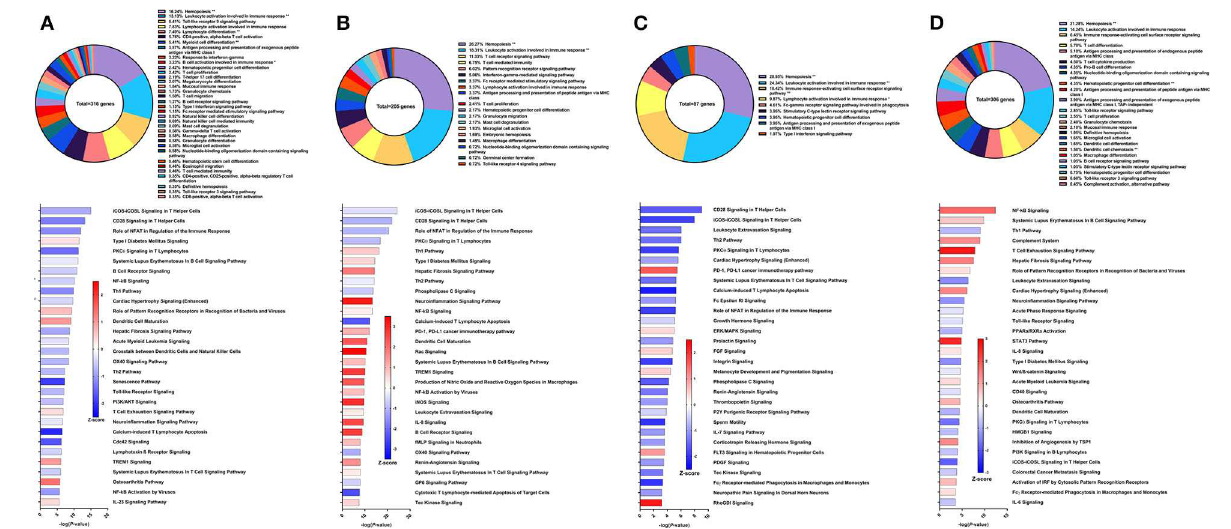
FIGURE 3 | RNA-Seq analysis of Sm-p80-VR1020 + rSm-p80 + ODN10104, a prime/boost vaccine strategy. (A) PBMCs after vaccination (Top) Gene ontology enrichment analysis represented as a pie graph of percentages of genes per group out of a total number of differentially expressed genes. “**” and “*” indicates P < 0.05 and P < 0.01, respectively. (Bottom) Canonical pathway analysis generated using IPA. Bars are plotted based on the – log10( P -value) and colored based on predicted activation (red) and deactivation/inhibition (blue) according to the Z-score, a composite assessment based on the degree of overlap between directional expression of genes from the observed data and the Qiagen-curated public database. The top 30 pathways are shown based on the lowest P -values. (B) PBMCs after challenge (Top) Gene ontology enrichment analysis. (Bottom) Canonical pathway analysis generated using IPA. (C) Spleen cells (Top) Gene ontology enrichment analysis. (Bottom) Canonical pathway analysis generated using IPA. (D) Mesenteric lymph node cells (Top) Gene ontology enrichment analysis. (Bottom) Canonical pathway analysis generated using